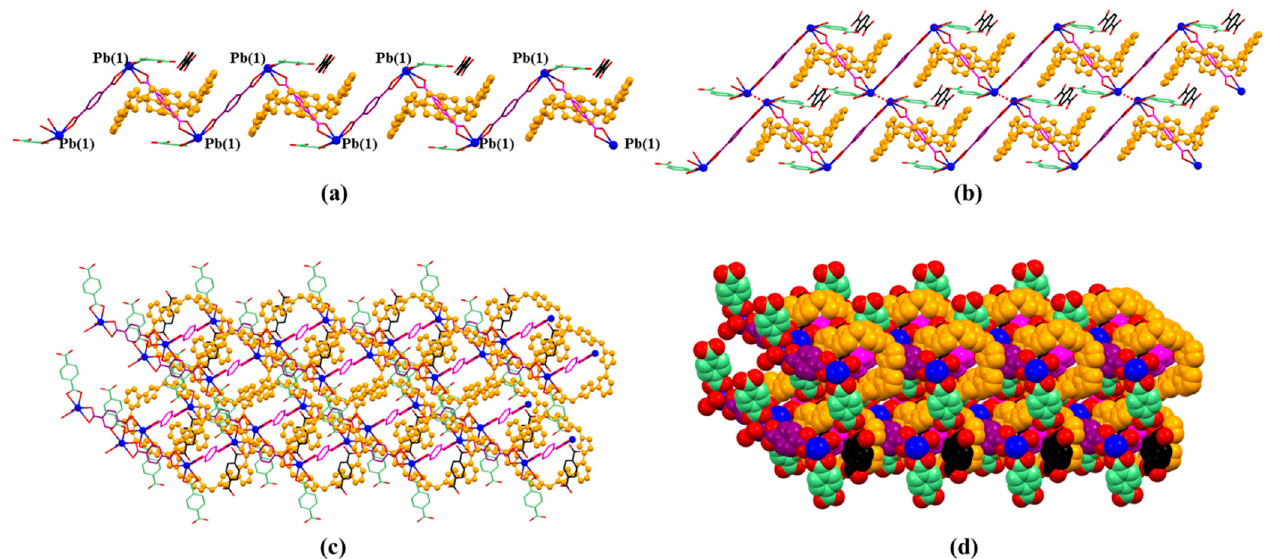
Figure 7. ( a ) 1D polyrotaxane, ( b ) 2D polyrotaxane network structure present within the single crystal X-ray structure of [ 1 4+ • ( 2 ) 4 • (2H + • 2 ) • Pb 2 • 2DMF • 12H 2 O] (MORF-Pb-1). Overall structure as wire frame ( c ) or space filling ( d ) form represen- tations of the polyrotaxane 3D array within the single crystal X-ray structure of [ 1 4+ •( 2 ) 4 •(2H + • 2 )•Pb 2 •2DMF•12H 2 O] (MORF-Pb-1). Note: Different colours are used for the linkage anions to illustrate the different local chemical